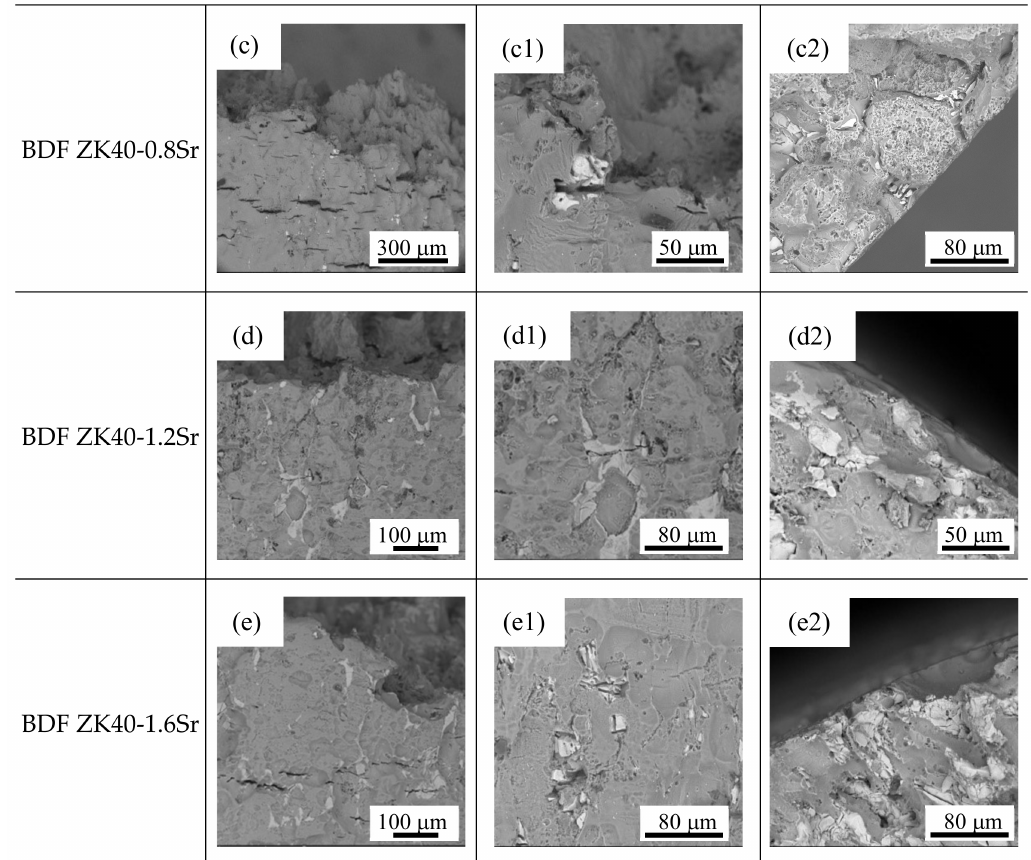
Figure 9. Scanning electron microscope (SEM) micrographs (backscattered electron images) of the BDF ZK40-xSr fractured surface in m-SBF: ( a – e ) typical fracture side surface appearance; ( a1 , b1 , c1 , d1 , e1 ) Partial enlarged view of fracture side surface revealing crack initiation; ( a2 , b2 , c2 , d2 , e2 ) edge of the fracture revealing crack